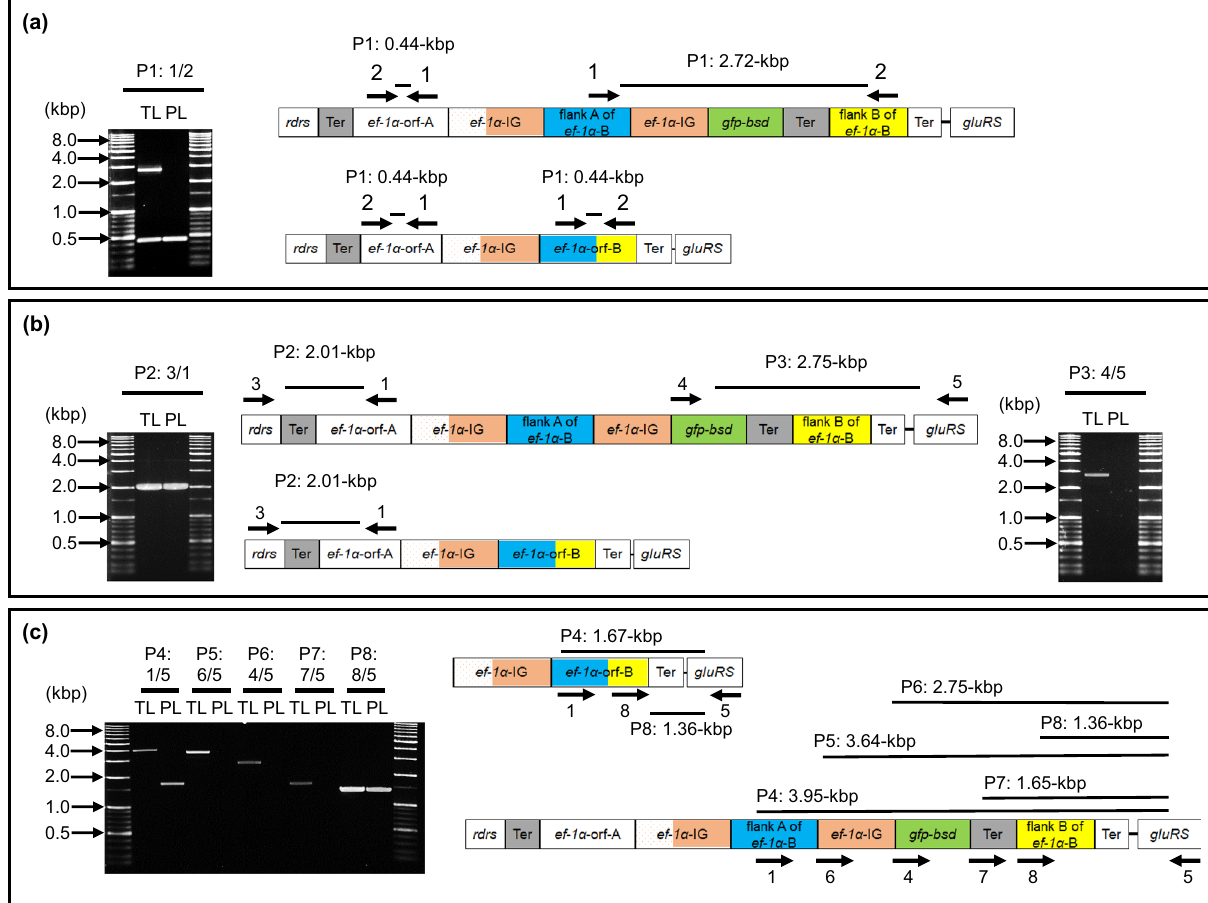
Figure 4. Graphical illustration of genomic integration of the enhanced green fluorescent protein/blasticidin S deaminase (eGFP/BSD)-expression cassette in transgenic T . equi . Genomic DNA extracted from the transgenic T . equi line (TL) and parental line (PL) was subjected to PCR assays. ( a ) A PCR assay (P1) confirmed the integration of the eGFP/BSD-expression cassette into one of the two elongation factor-1α ( ef-1α ) gene loci. ( b ) Two PCR assays (P2 and P3) confirmed that integration of the eGFP/BSD-expression cassette had occurred in the ef-1α-B gene locus. ( c ) Five PCR assays (P4–P8) confirmed the integration and correct orientation of the eGFP/BSD-expression cassette components in the ef-1α-B gene locus of the transgenic T . equi . A 1000 base-pair DNA ladder marker was used in all